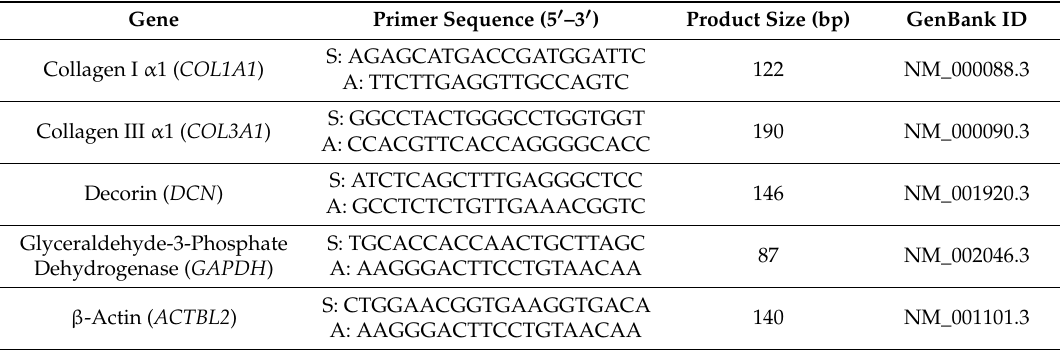
Table 3. Sequence of sense (S) and antisense (A) primers used in the real-time polymerase chain reaction (PCR) of reference and target genes. Base pairs